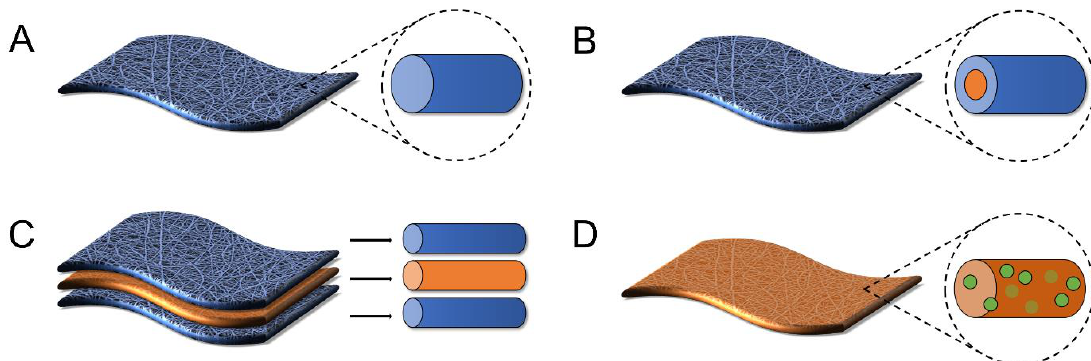
Figure 3. Schematic of different electrospun fiber composites. Diagrams representing ( A ) traditional uniaxial fibers, ( B ) coaxial fibers, ( C ) multilayered fibers, and ( D ) nanoparticle-fiber composites. ( A ) Uniaxial fibers are comprised of a single polymer or polymer blend (shown in blue) that is distributed homogenously throughout the fiber structure. ( B ) In contrast, coaxial fibers contain both core (orange) and shell (blue) layers that are chemically distinct. ( C ) Multilayered fibers result from sequentially electrospinning different fiber layers together or integrating individual layers post-fabrication. ( D ) Finally, nanoparticle-fiber composites consist of hydrophilic or hydrophobic fibers (orange) that encapsulate nanoparticles (green).